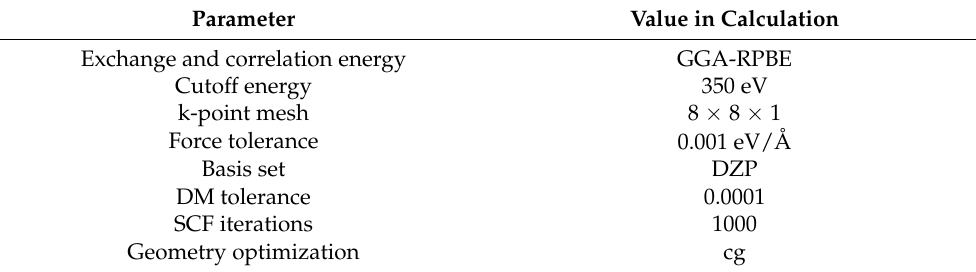
Table 1. Parameters and associated values used for the